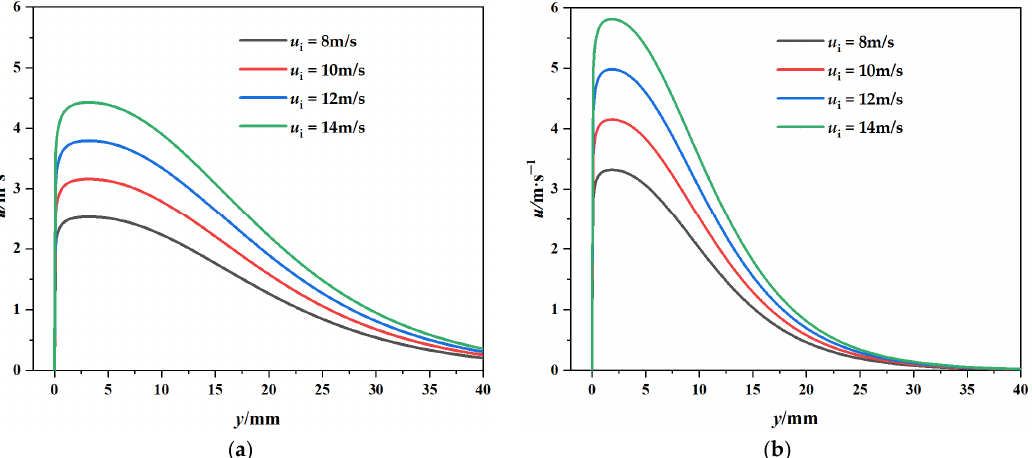
Figure 5. Velocity distribution with different u i over logarithmic spiral wall surfaces at ( a ) x / R = 1 and ( b ) x / R = 2/3.